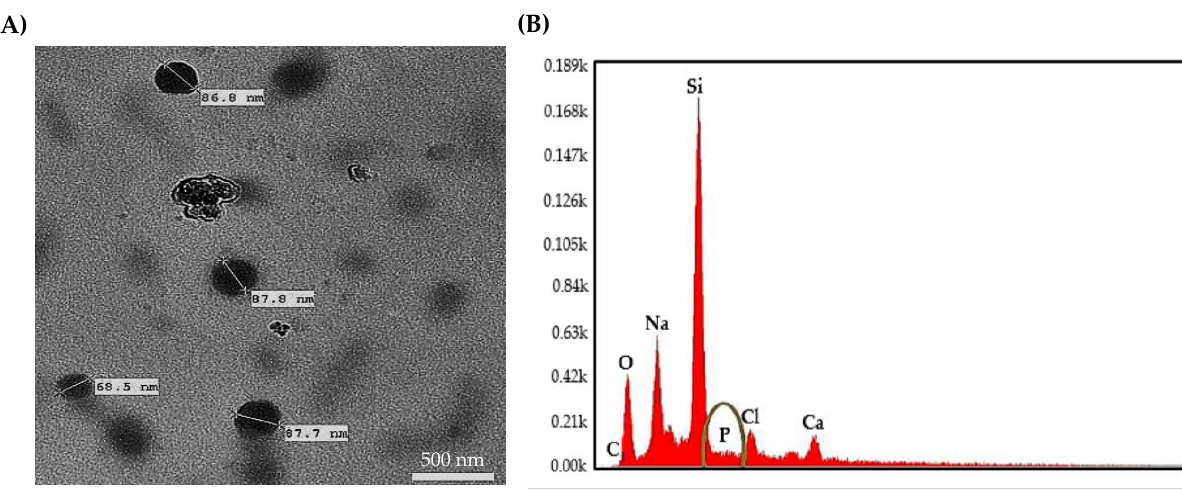
Figure 1. Characterization of the synthesized nanovehicles by ( A ) transmission electron microscopy and ( B ) energy dispersive X-ray. The spectra elucidated the presence of a phosphorous peak, corresponding to the phosphorothioate (PS) backbone of the respective ODN. (Scale bar = 500 nm; magnification = 10,000X).